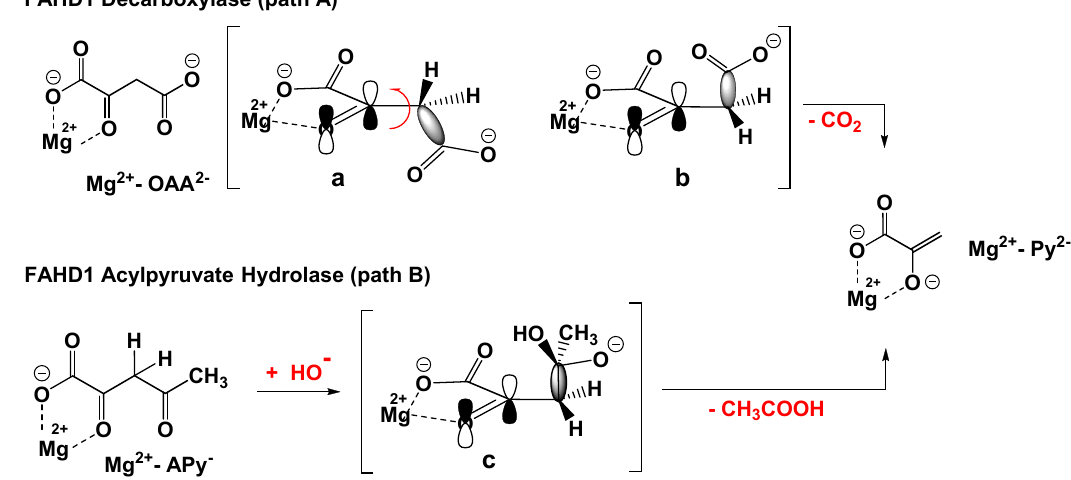
Figure 1. Orbital model for the ODx and ApH reactions catalyzed by FAHD1. Path A: ODx. Mg 2+ -OAA 2 − depicted in two conformations: not competent ( a ) and competent conformations ( b ) for decarboxylation and the formation of the pyruvate enolate complex Mg 2+ -Py 2 − (bent arrow indicates bond rotation); C–C bond cleavage under CO 2 evolution to the Mg 2+ -complexed enolate of pyruvate (Mg 2+ -APY 2 − ). Path B: ApH. Nucleophilic addition of hydroxyl to the 2-keto form of OAA 2 − ; ( c ) intermediate oxyanion already in a productive conformation is shown; C–C bond cleavage under the extrusion of acetic acid and formation of the pyruvate enolate complex Mg 2+ -Py 2 −